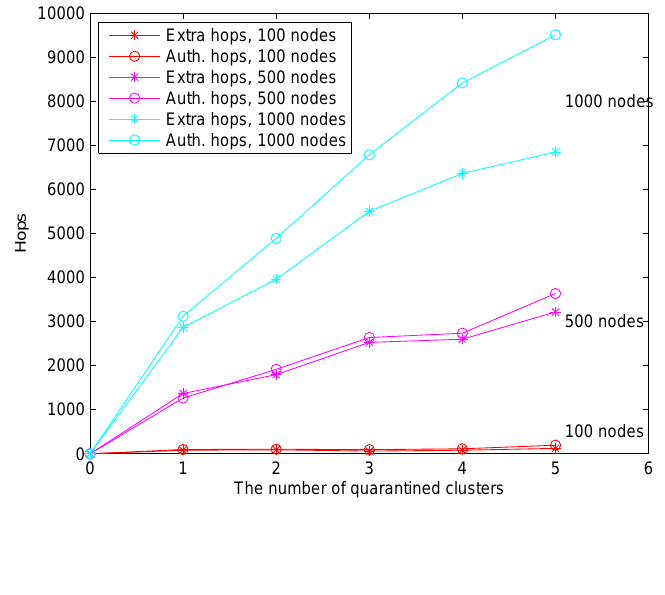
Figure 14. Case I: the number of extra hops for bypassing routing path and the number of authenticated hops for going through the quarantined